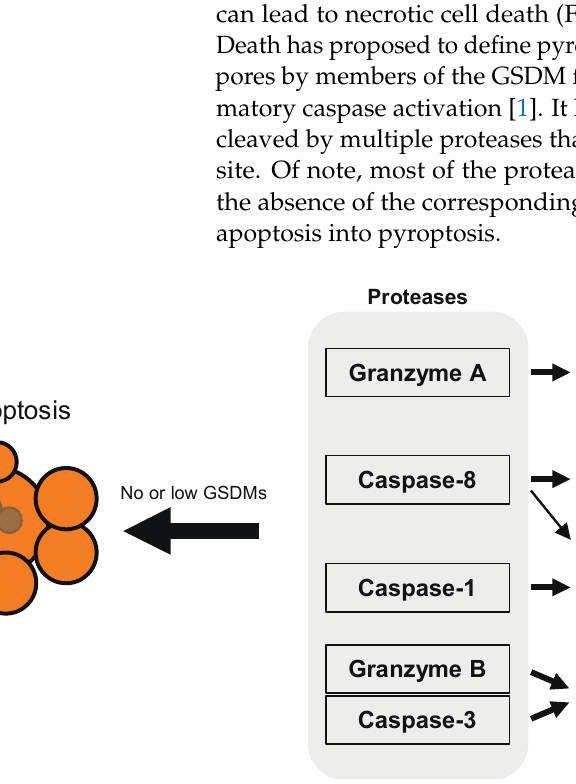
Figure 2. Proteases that activate GSDM members. GSDMB is processed by granzyme A into the active form; GSDMC by caspase-8; GSDMD by caspase-1, and to a lesser extent, by caspase-8; GSDME by caspase-3 and granzyme B. Of note, these GSDM-activating proteases can also induce or execute apoptosis or ROS-dependent, apoptosis-like cell death in cells that do not express sufficient levels of GSDMs for causing pyroptosis, in other words, caspase/granzyme-induced apoptosis can be switched to pyroptosis by the expression of GSDMs. GSDMD is also proteolytically activated by caspase-11/4/5, neutrophil elastase, and cathepsin G.